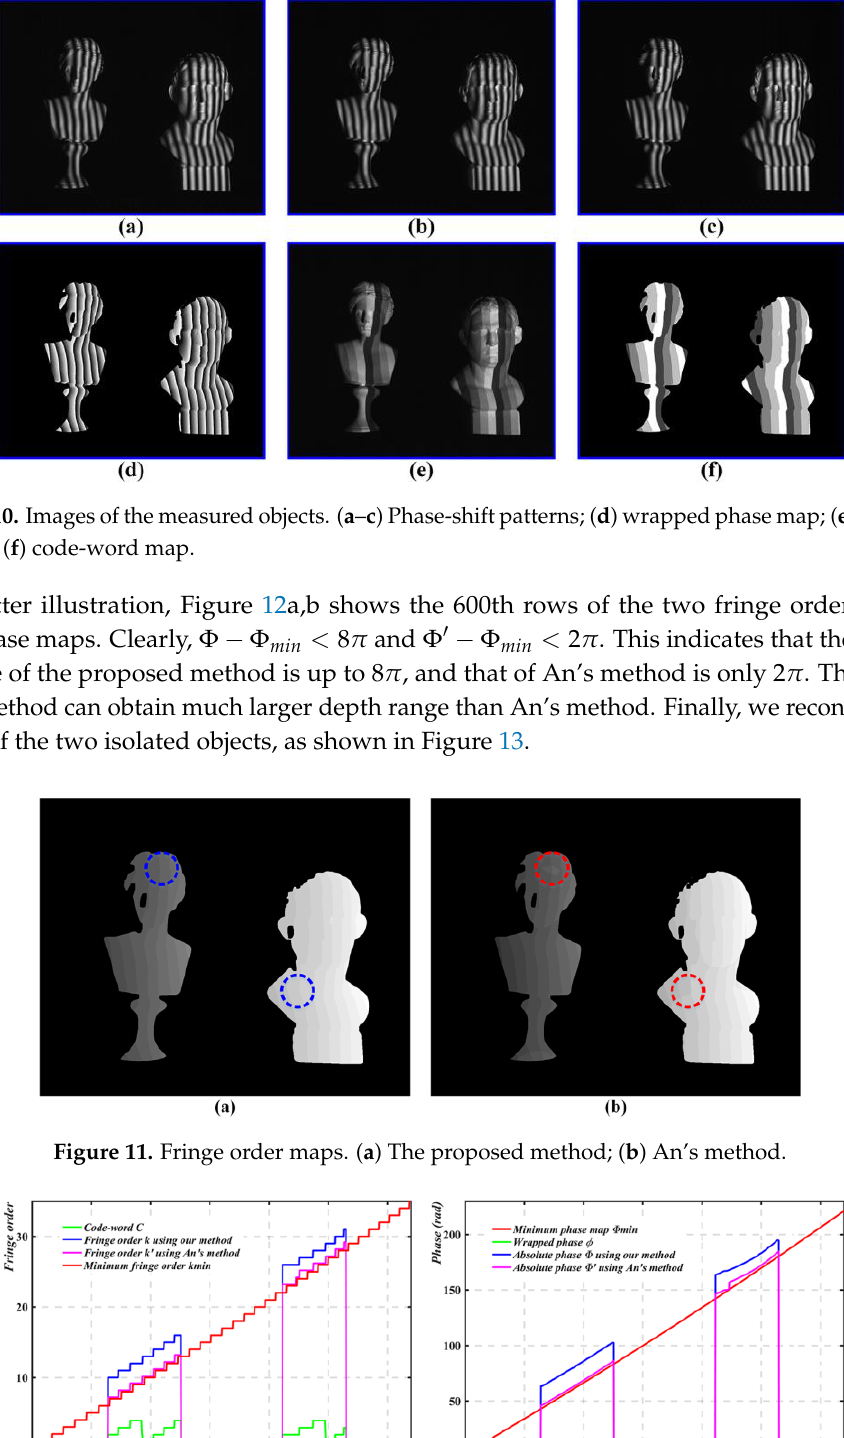
Figure 11. Fringe order maps. ( a ) The proposed method; ( b ) An’s method .